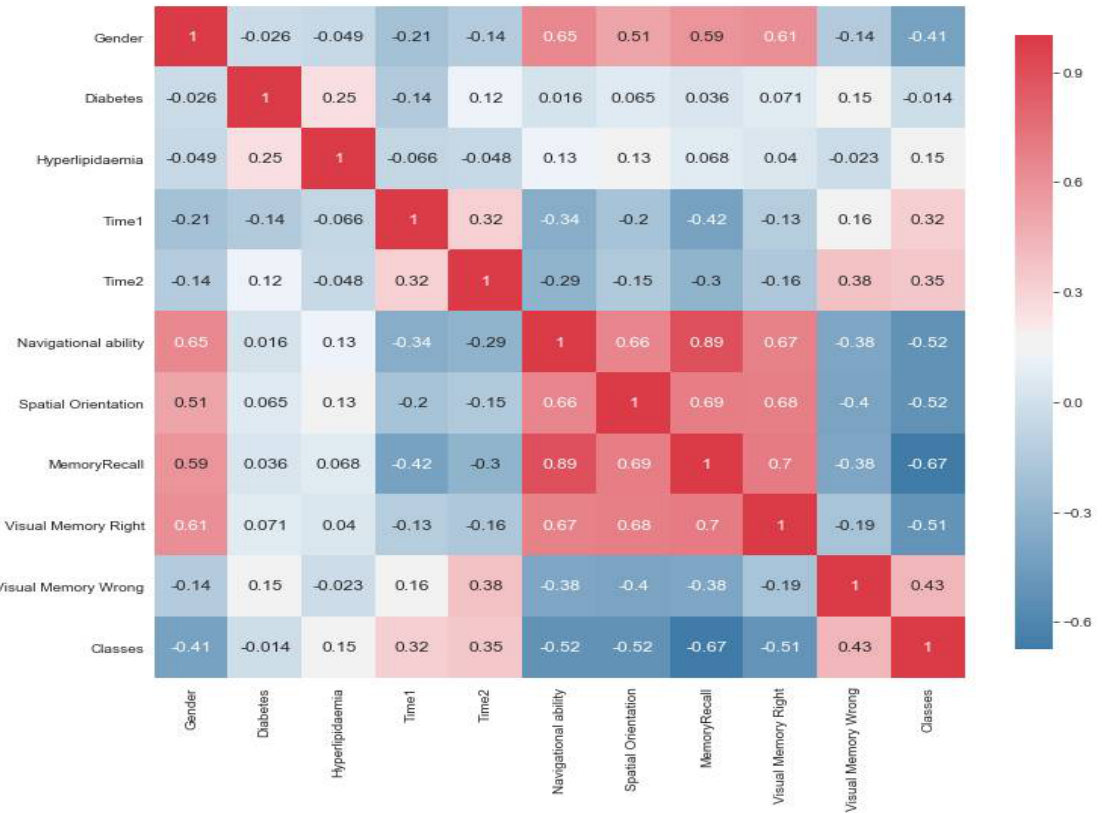
Figure 4. Plot of the heatmap correlation between attribute features.